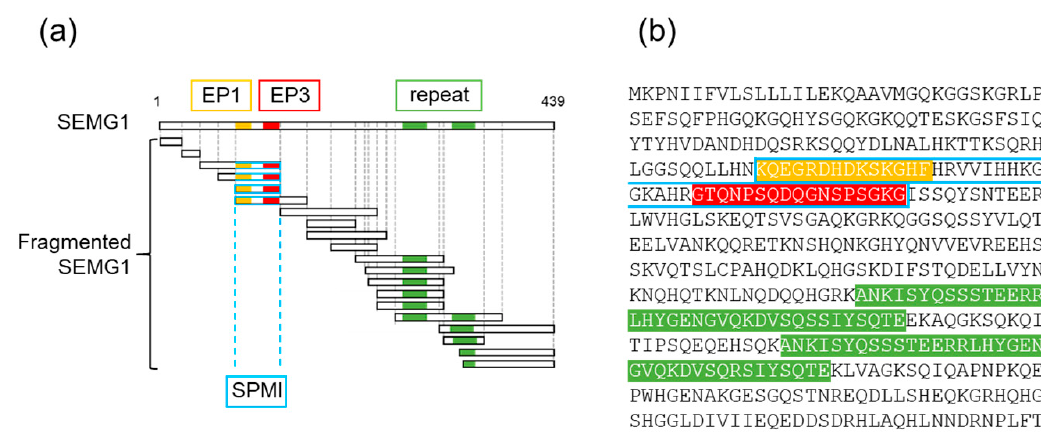
Figure 2. Protein structures of human SEMG1. ( a ) Localization of three polypeptides used in this study. Fragmented SEMG1 is naturally generated in human ejaculated semen by proteolytic activity of prostate-specific antigen (PSA) secreted by the prostate (blue square) [28]. Colors indicate individual polypeptides localized in SEMG1 fragments. ( b ) Amino acid sequences of human SEMG1. Colors indicate individual polypeptides shown in Figure 1( c ) and ( d ).